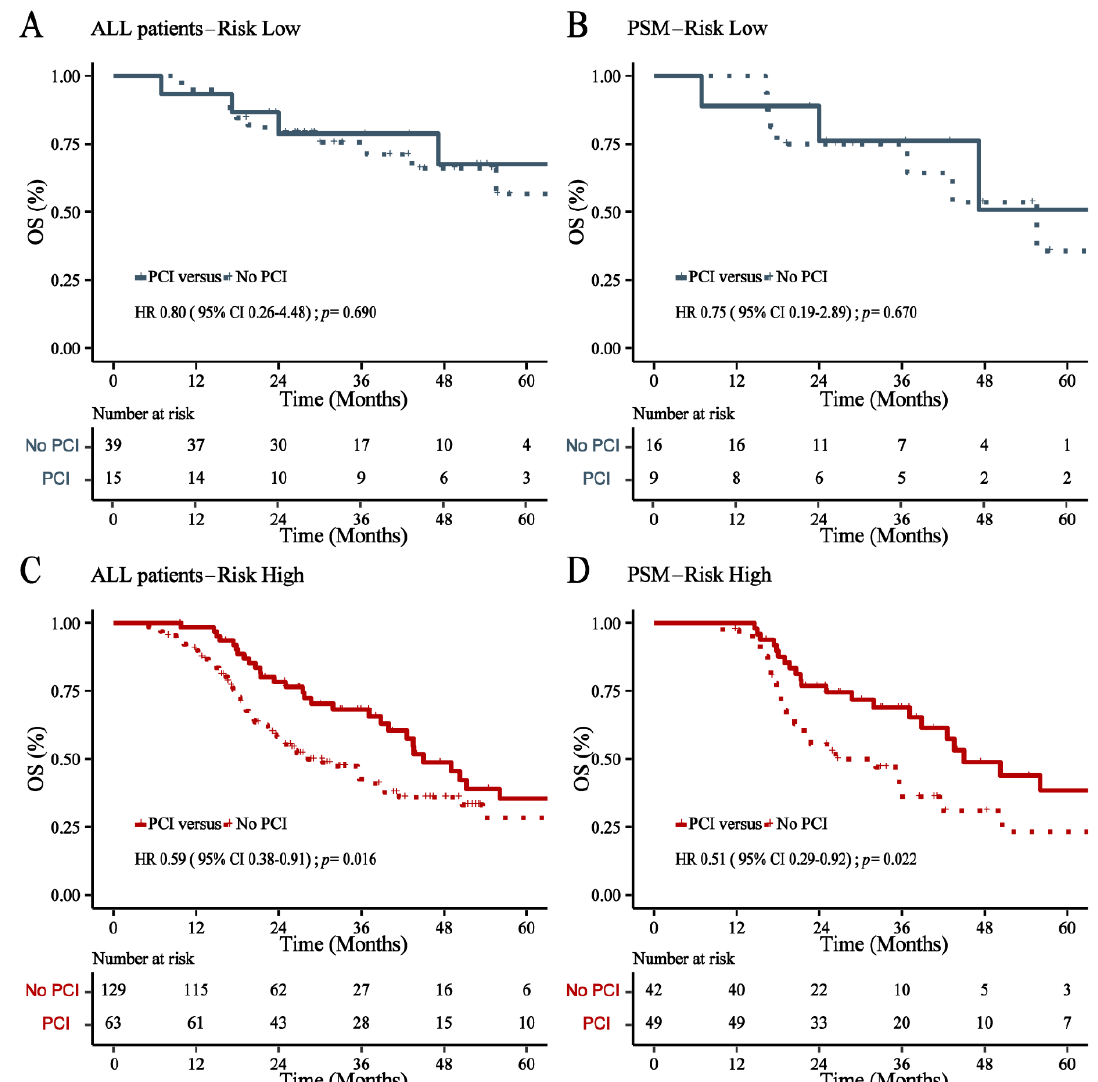
Figure 8. Overall survival (OS) in the low-risk cohort ( A ) and high-risk cohort ( C ) before matched, and after PSM ( B , D ).